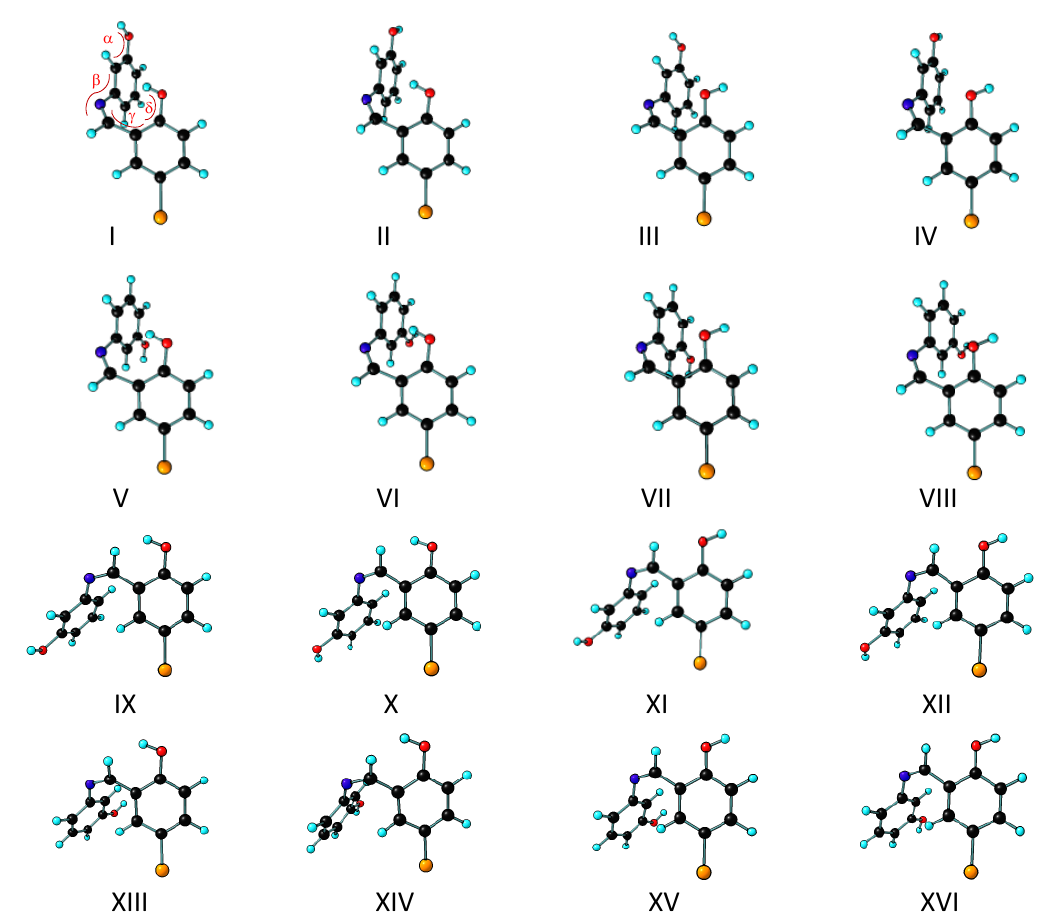
Figure 3. Conformers of the BHAP Z -enol-imine form. The B3LYP/6-311++G(d,p) calculated optimized Cartesian coordinates of each conformer are provided in the Supporting Information Table S1. The conformationally relevant dihedral angles α , β , γ , δ are indicated over the structure of conformer I. Note that all conformers have a symmetry related structure.